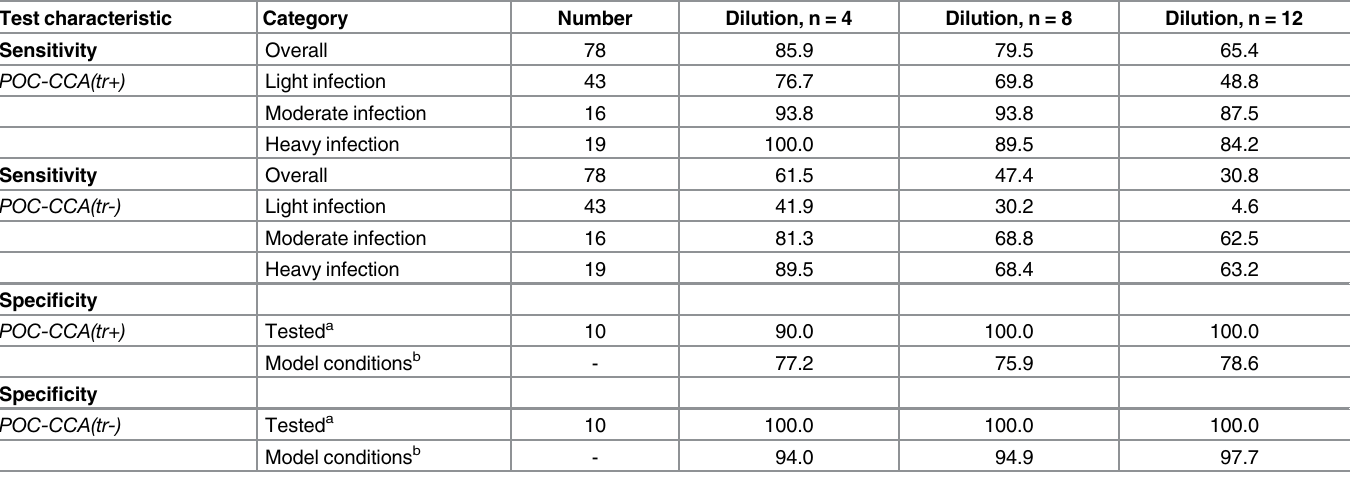
Table 3. Sensitivity and specificity of the POC-CCA test with a urine pooling strategy.